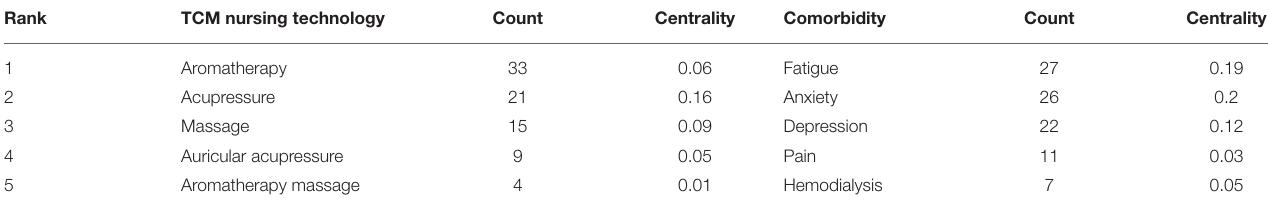
TABLE 7 | Top 5 TCM nursing technology treatment and insomnia comorbidity in terms of frequency and centrality.